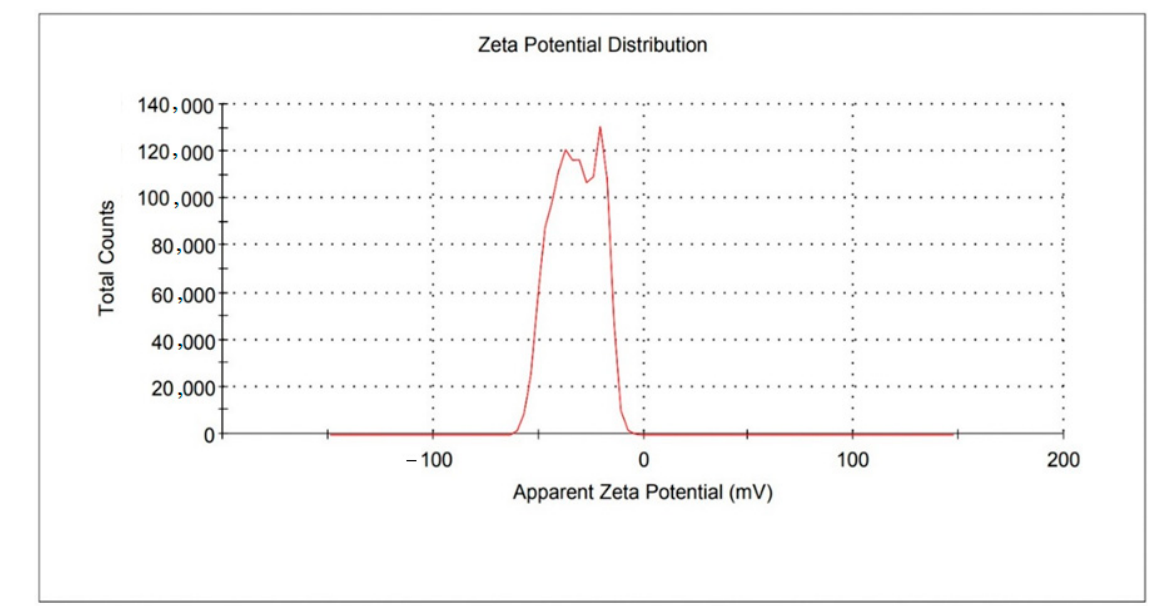
Figure 1. Mean particle size of the optimized FS3.